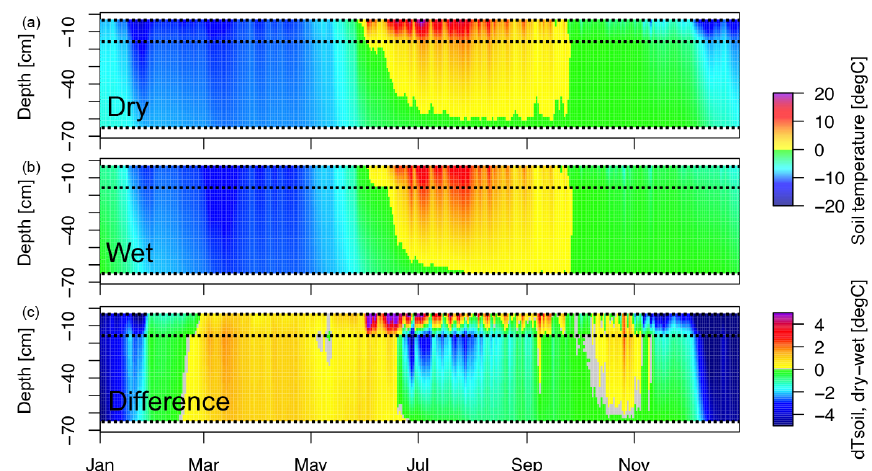
Figure 7. Daily mean soil temperature profiles at a dry (a) and wet (b) micro-site within the drained transect, and the difference (dry–wet, c ) for the calendar year 2015. Data for three measurement depths (dotted lines) are linearly interpolated along the vertical profile. Values in the difference plot were truncated to the range [ − 5; 5] ◦ C to enhance visibility of fine-scale patterns, while values fell within the range [ − 11.3; 10.5] ◦